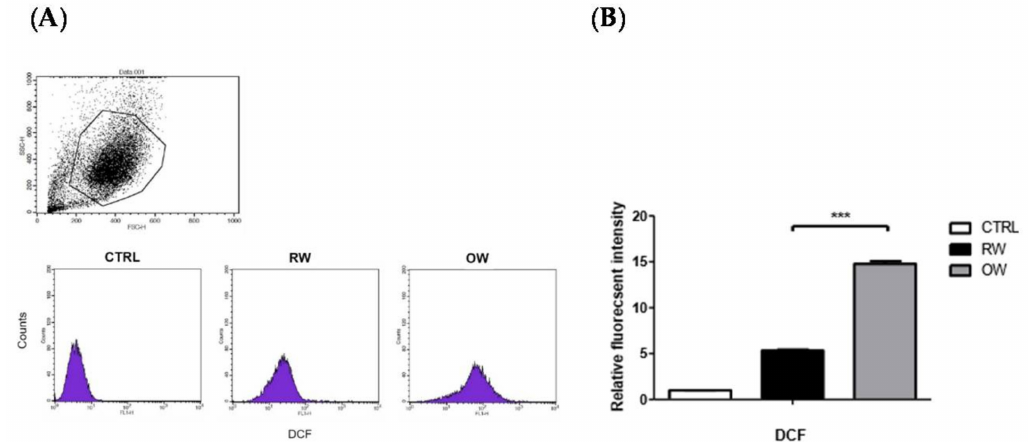
Figure 4. E ff ects of oxygenated water on oxidative stress in mature adipocytes. Mature adipocytes were pre-incubated with either OW or RW for 4 h then stained with the fluorescent dye (H 2 DCFDA) for 30 min. Fluorescent intensity of the H 2 DCFDA was detected by flow cytometry ( A ) and quantified ( B ). Data are presented as mean ± S.E.M. ( n = 4) and were statistically analyzed by two-tailed unpaired Student t-tests, *** p <